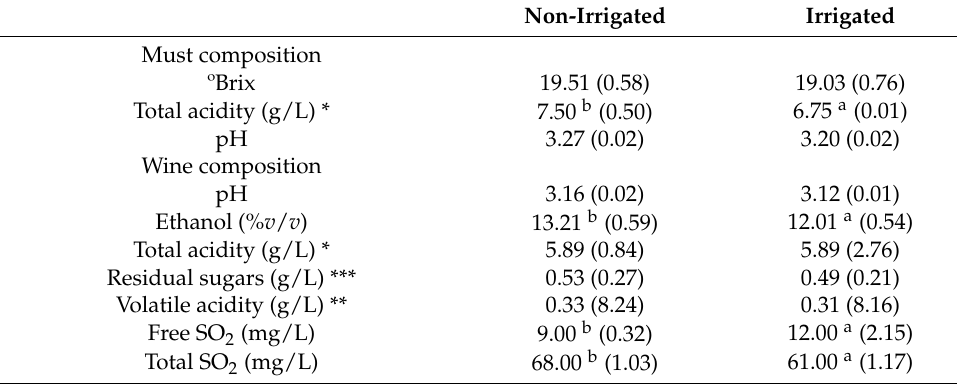
Table 1. Enological parameters of Chelva musts and wines made with grapes from non-irrigated and irrigated vines. Mean concentrations and relative standard deviations ( n =